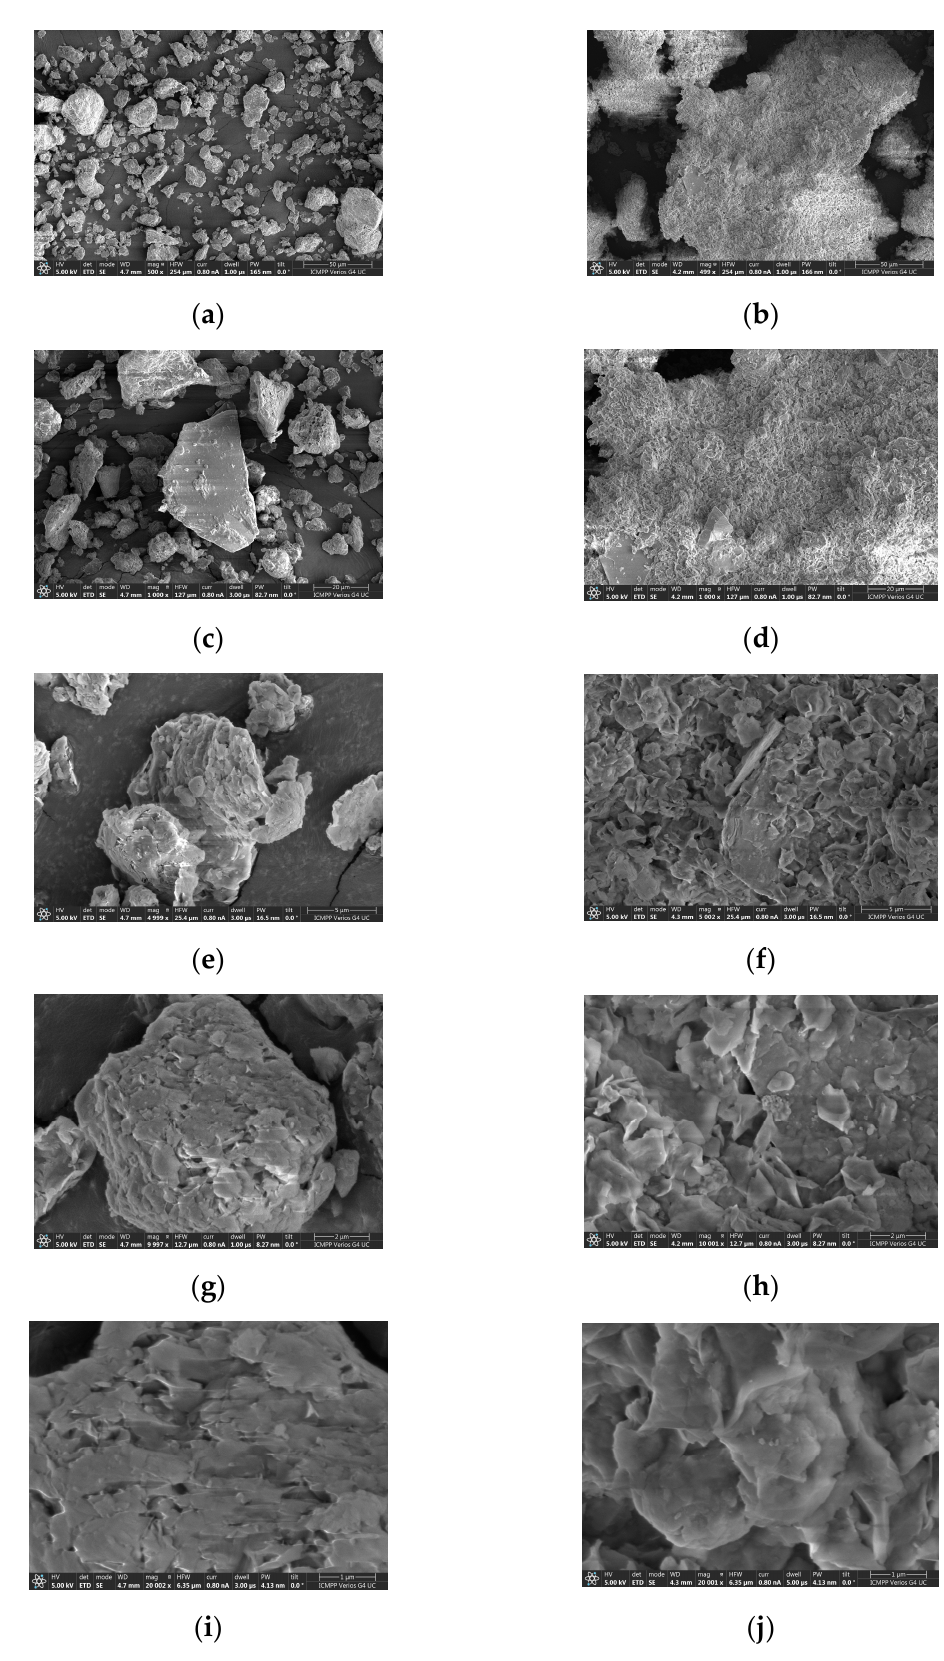
Figure 1. SEM analysis for BN ( a , c , e , g , i ), and for BN-Ag 0 ( b , d , f , h , j ) samples at different units scale: 50 µm ( a , b ), 20 µm ( c , d ), 5 µm ( e , f ), 2 µm ( g , h ) and 1 µm ( i , j